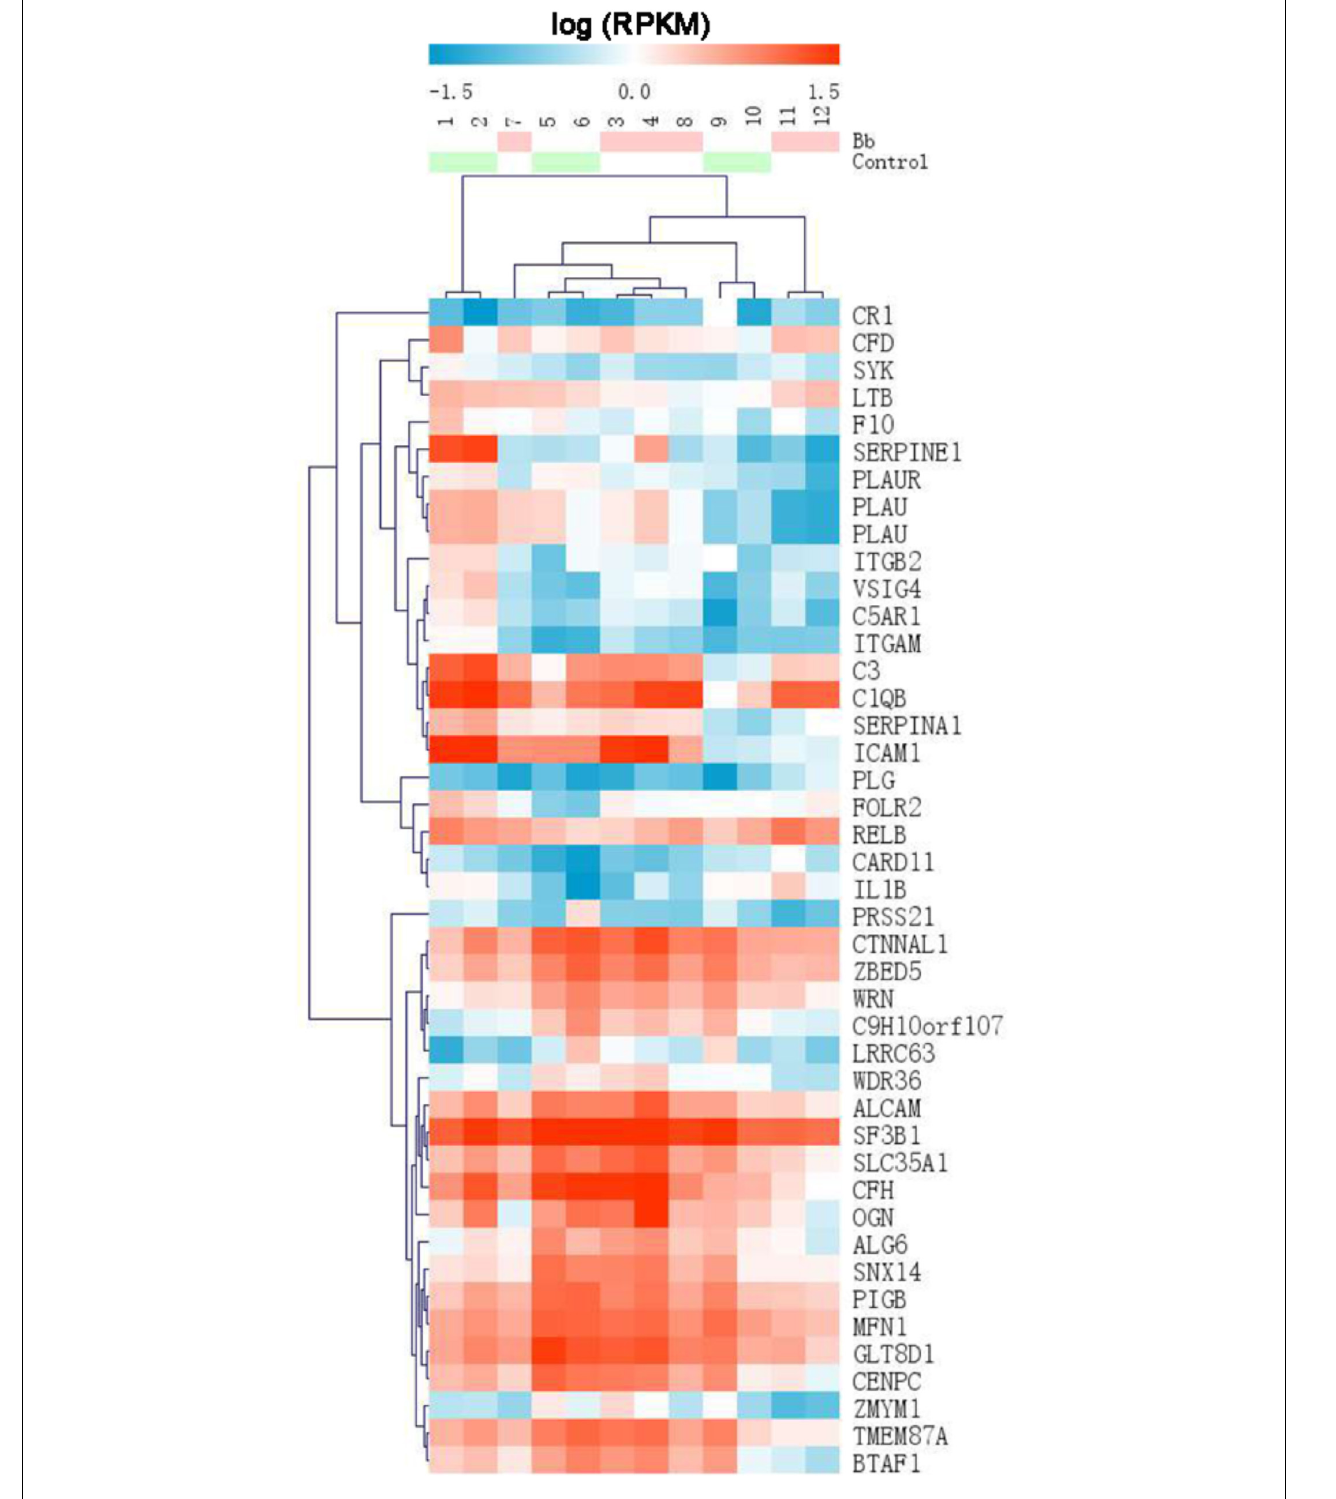
FIGURE 3 | Heatmap of DEGs identified by RNA sequencing showing the hierarchical clustering of the relative expression of a portion of the DEGs in each sample, for the sake of brevity. The Bb group and control group are represented by red and green, respectively. High and low abundance of gene expression are shown in red and blue,